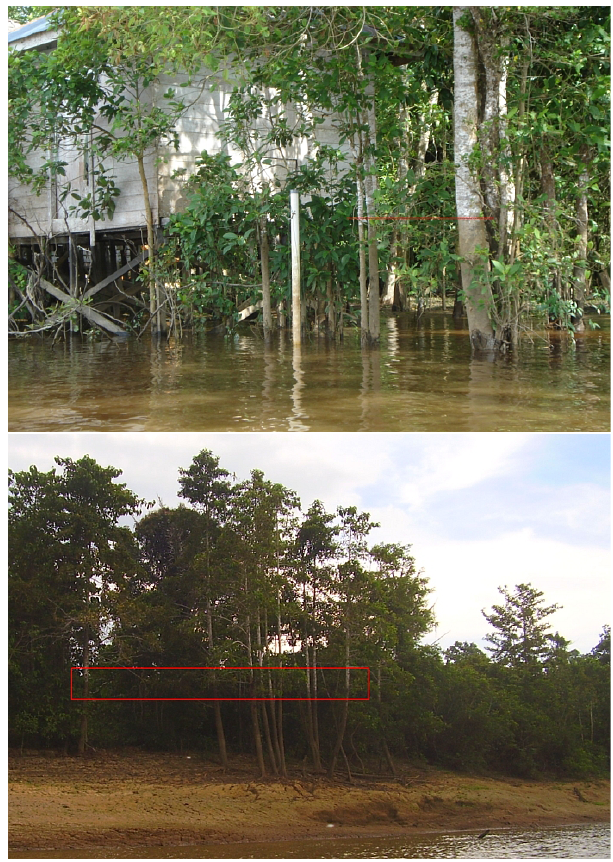
Fig. 3. (top) River bank overtopping in Penyinggahan during the high water event in March 2009. The red line indicates water level marks on trees, from a previous flood event. (bottom) A view to the floodplain upstream of the MMA during low water event in August 2009. Flood marks on trees (red rectangle) indicate the height of the previous inundation in the vegetated floodplain